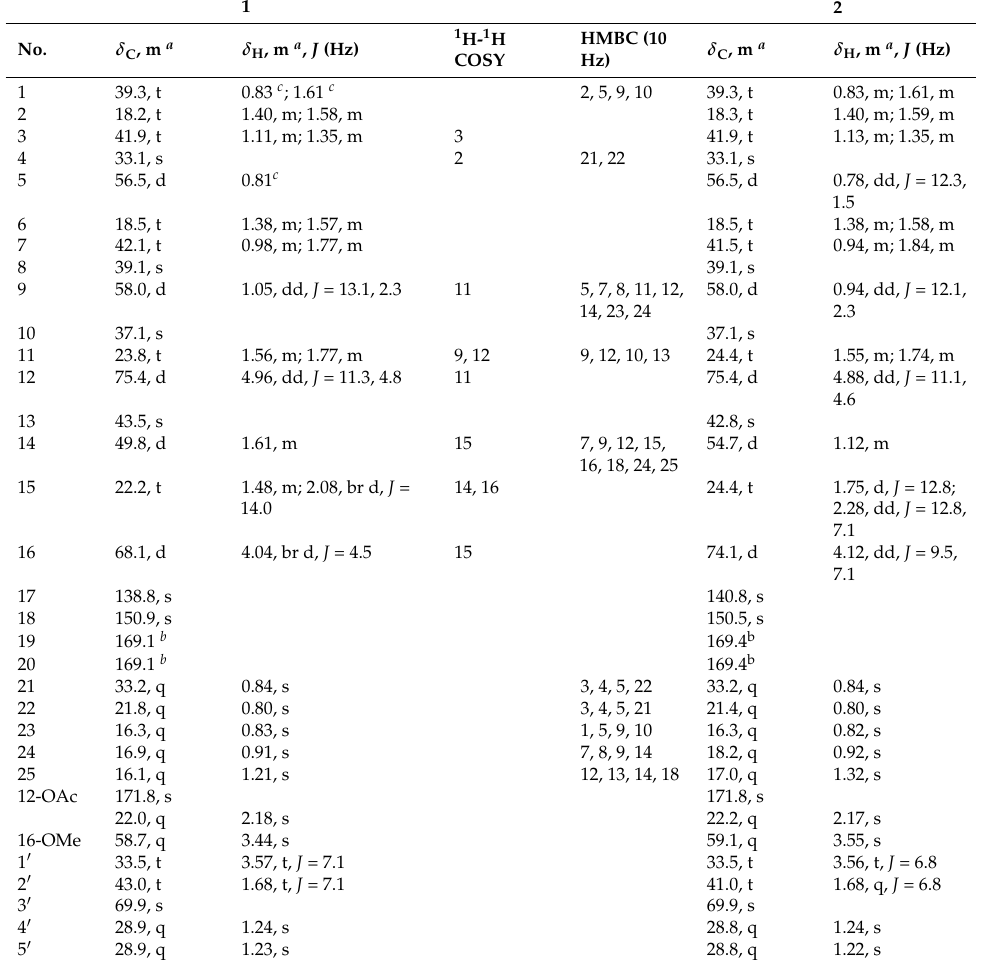
Table 1. NMR spectroscopic data of 1 and 2 in CDCl 3 at 600